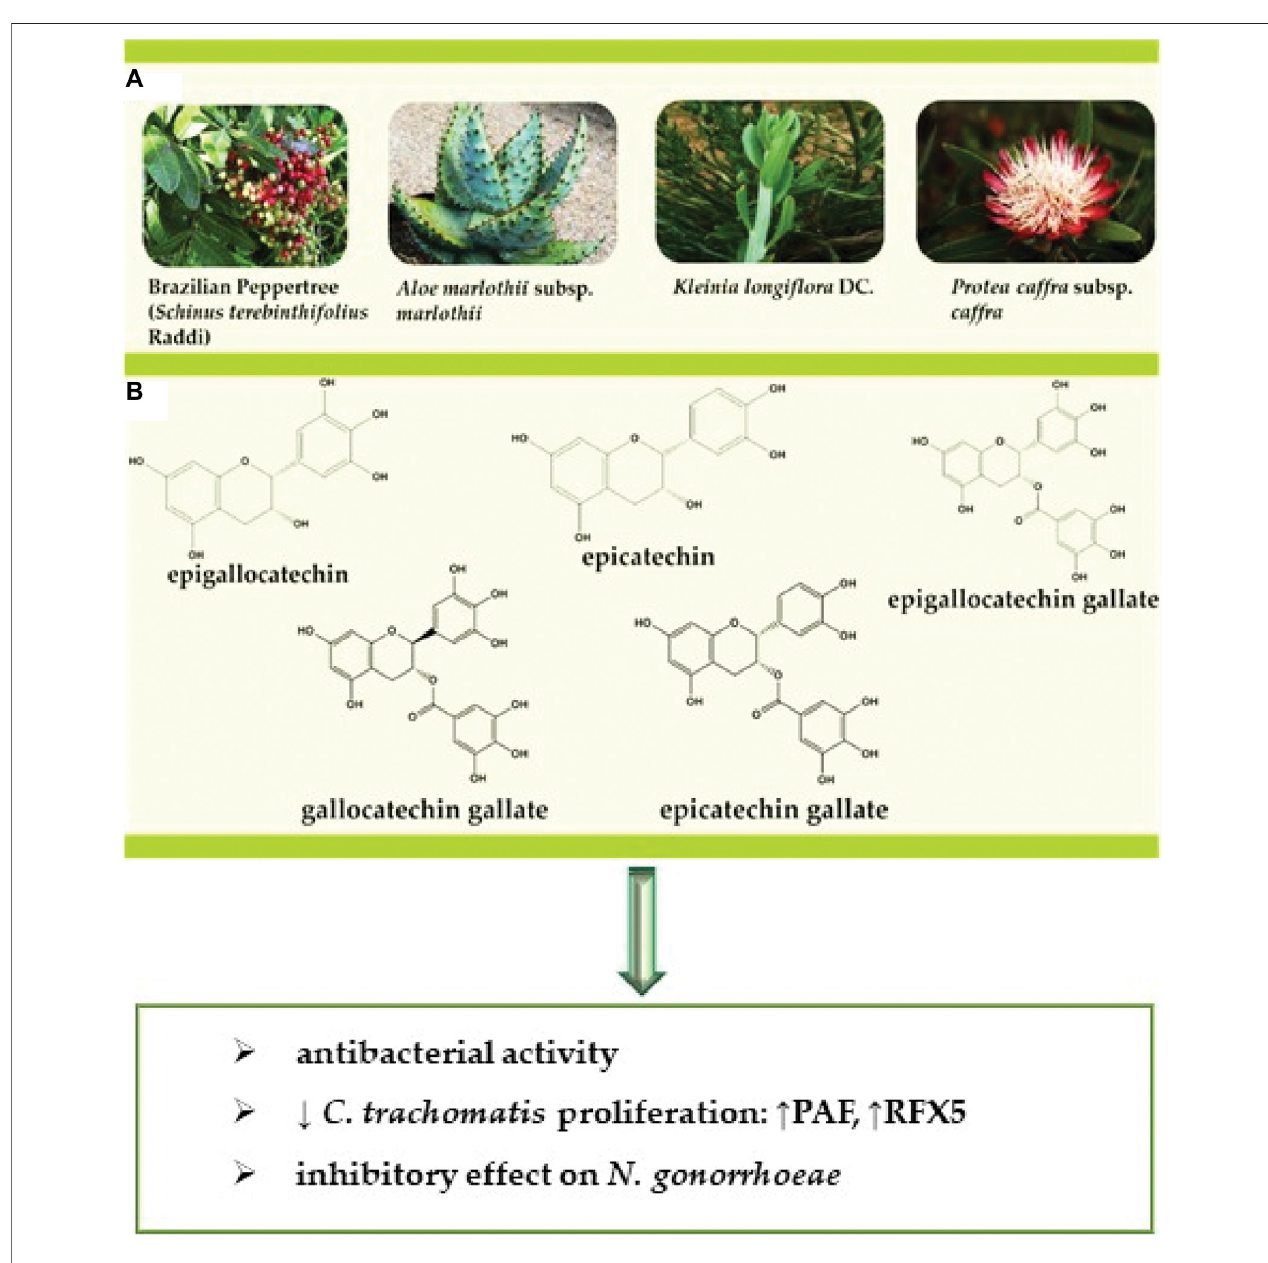
FIGURE 2 | (A) Representation of the selected bioactive plant species (B) structures of the bioactive compounds against STDs caused by bacteria. Abbreviations and symbols: ↓ decrease, chlamydial protease-like activity factor (CPAF), regulatory factor X-5 (RFX5).